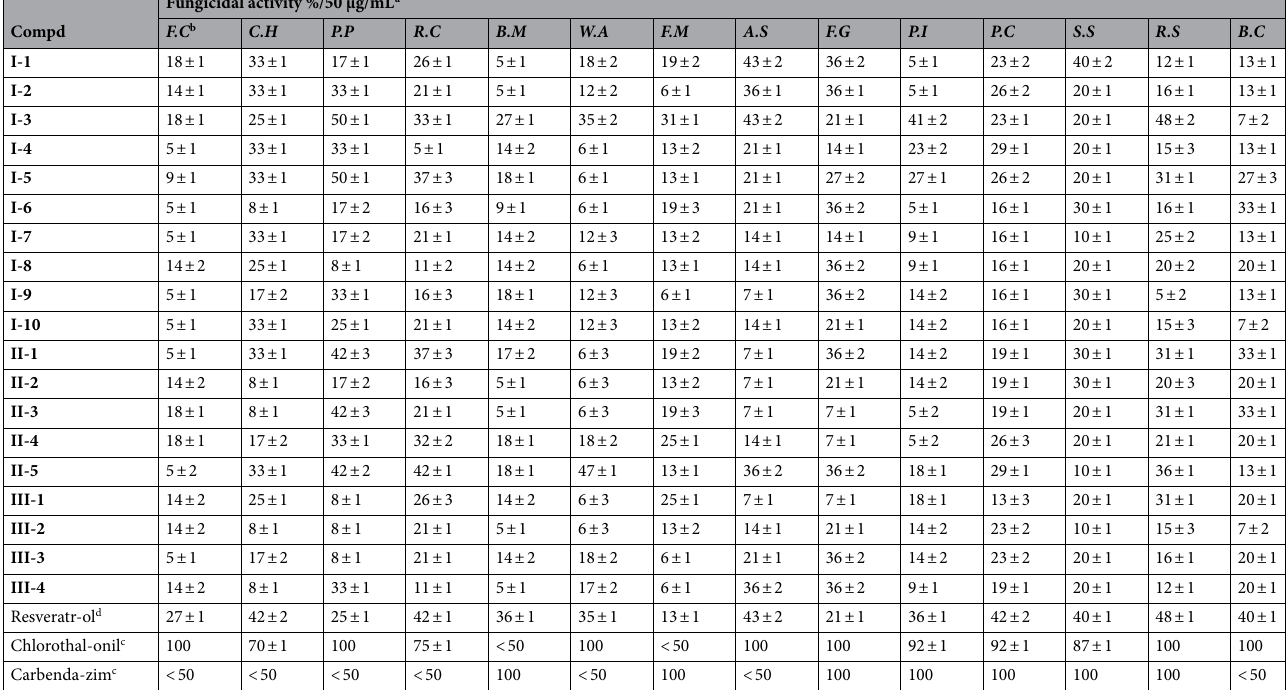
Table 2. Fungicidal activity of the compounds I-1–I-10 , II-1–II-5 and III-1–III-4 against 14 kinds of phytopathogens. a Average of three replicates. All results are expressed as the mean ± SD. b F.C, Fusarium